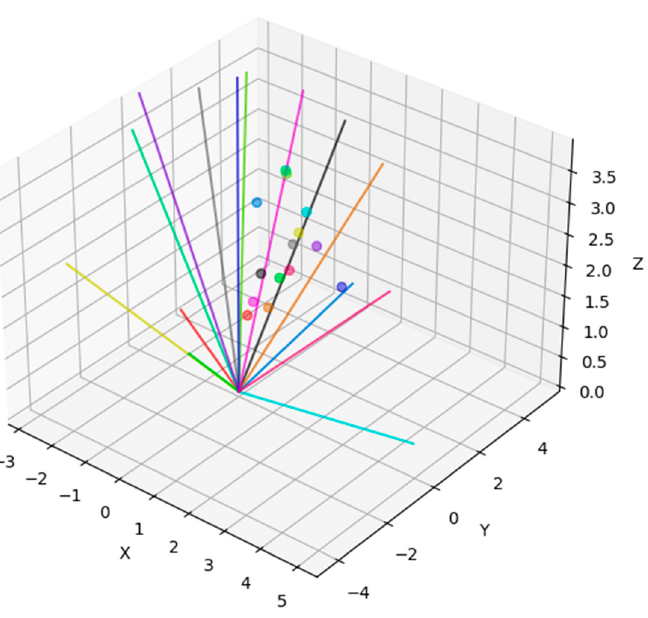
Figure 2. PNP scenario which fails the second Lasserre level (same colors for line-point pairs).